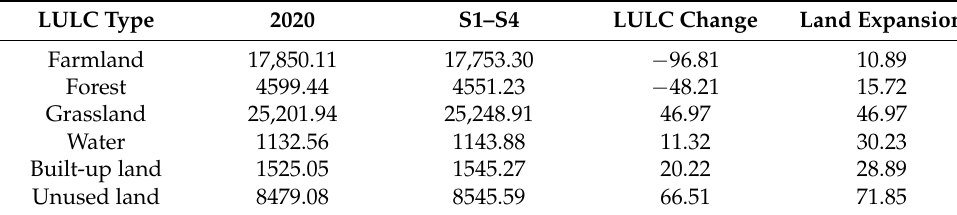
Table 4. Simulated results of LULC in 2035 compared to that in 2020.